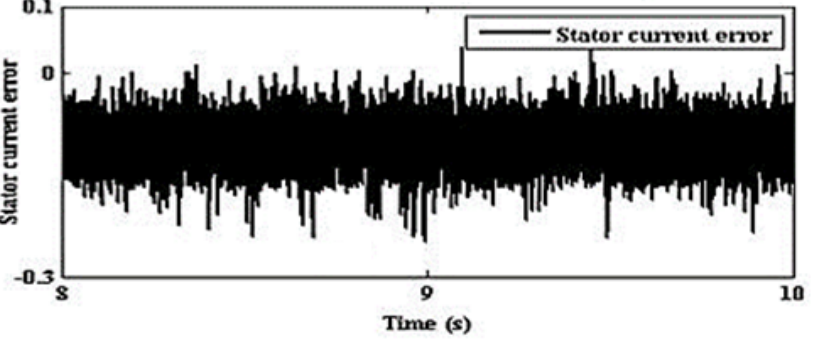
Energies 2020 , 13 , x FOR PEER REVIEW Figure 14. SMLO1 stator current error. Figure 14. SMLO1 stator current error. Figure 14. SMLO1 stator current error.